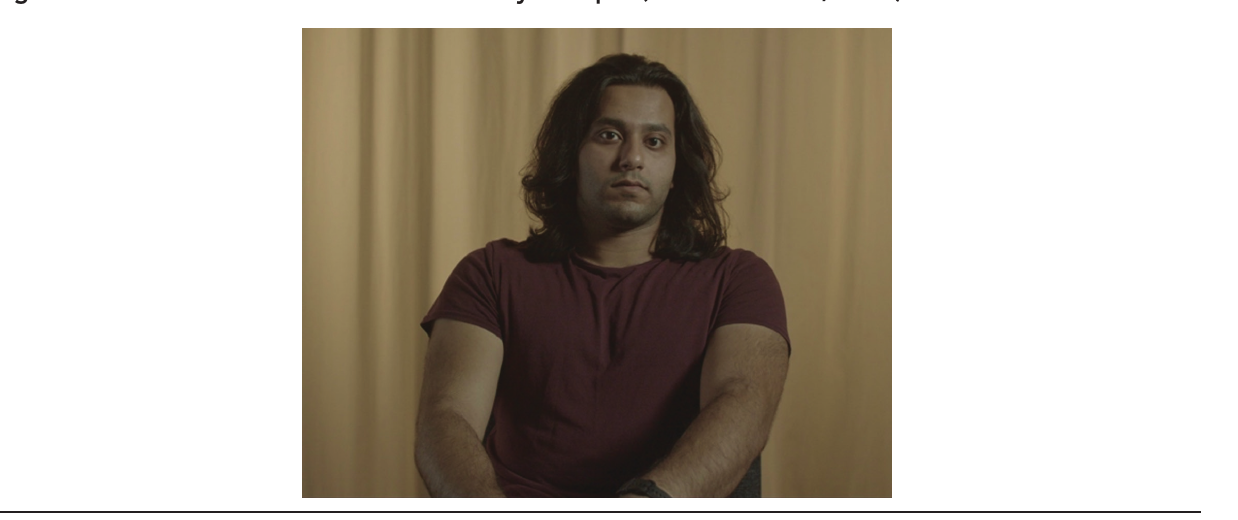
Figure 8. Medium shot with cheerful mood by Group 1 (Source: Author, 2022)